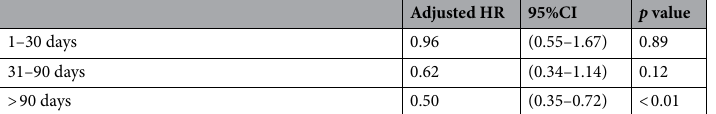
Table 4. Risk of K. pneumoniae liver abscess adjusted for in-hospital mortality as a competing risk. CI, confidence interval; HbA1c, glycated hemoglobin; HR, hazard ratio. *Due to the small number of patients, unspecified liver injury, other viral hepatitis (exclude hepatitis B and hepatitis C), and centrally acting anti- adrenergic agents were not considered in the